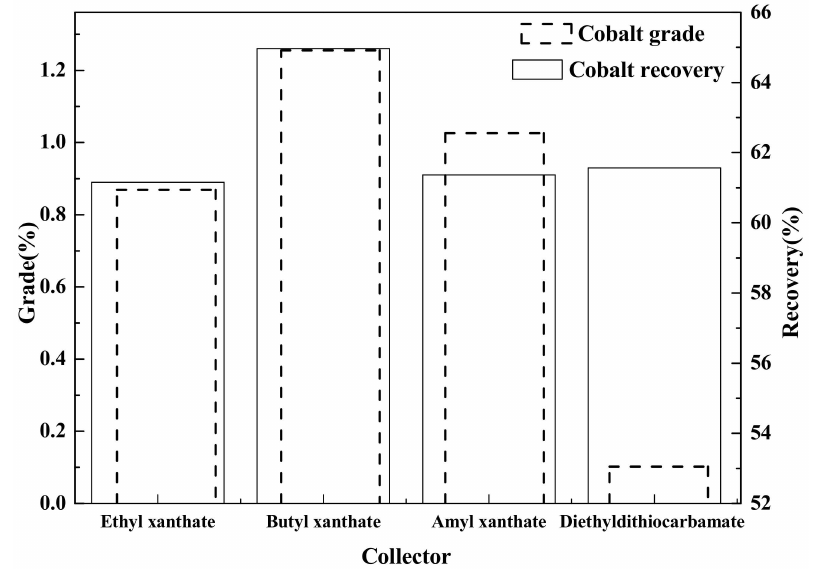
Figure 2. E ff ect of collectors on cobalt grade and recovery in